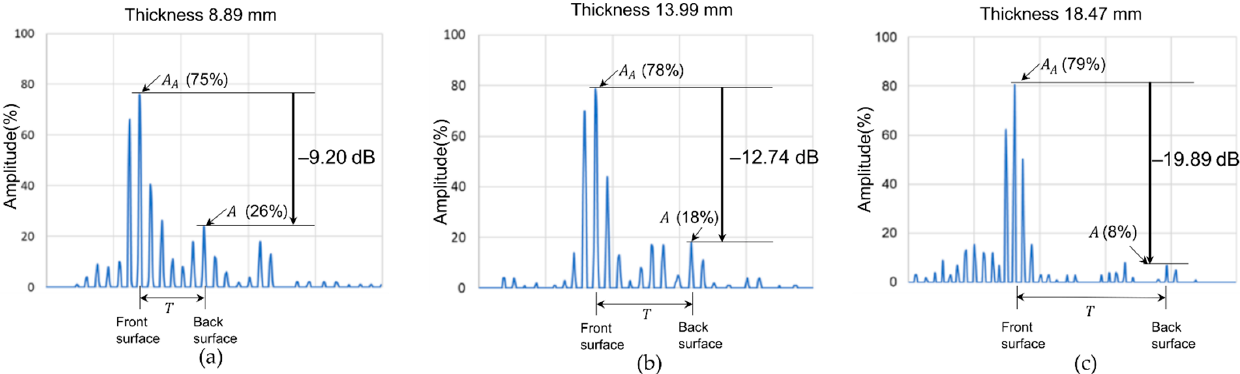
Figure 8. Ultrasonic A-scan results for each type of plate in the thickness variation group. ( a ) Thickness = 8.89 mm. ( b ) Thickness = 13.99 mm. ( c ) Thickness = 18.47 mm. Table 4. Characteristics of and attenuation analysis results for each plate in the thickness variation group.